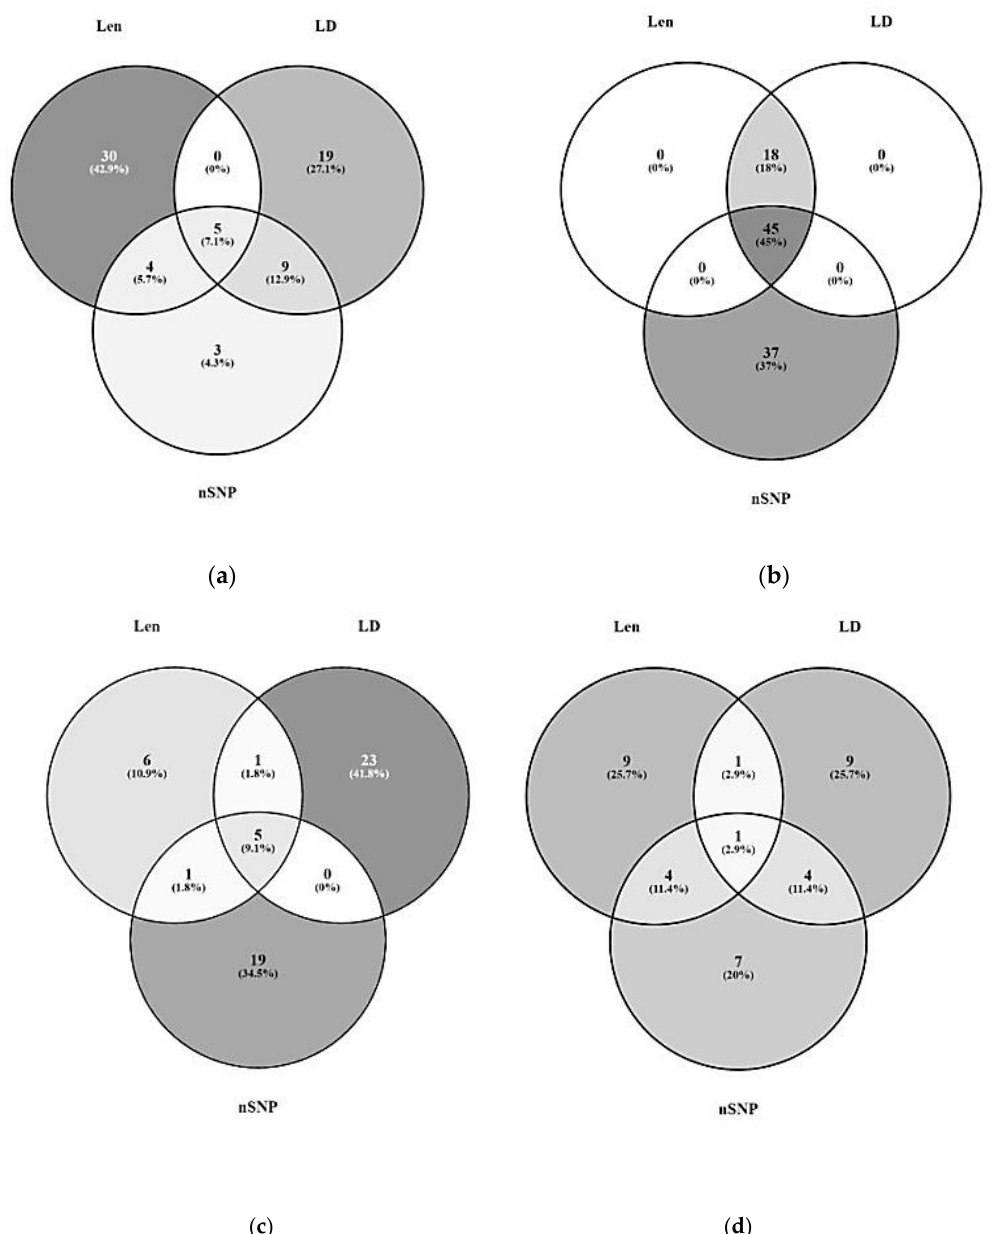
Figure 2. Number of genes unique and common among three methods for ( a ) BFT, ( b ) CWT, ( c ) EMA, and ( d ) MS.